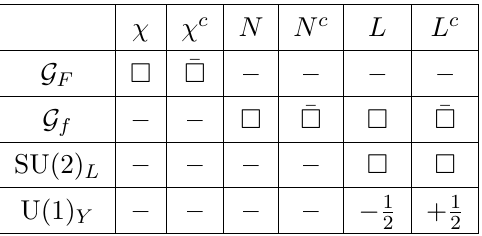
Table 1 . Matter content on the IR brane with gauge representations for the model with a barrier at the electroweak